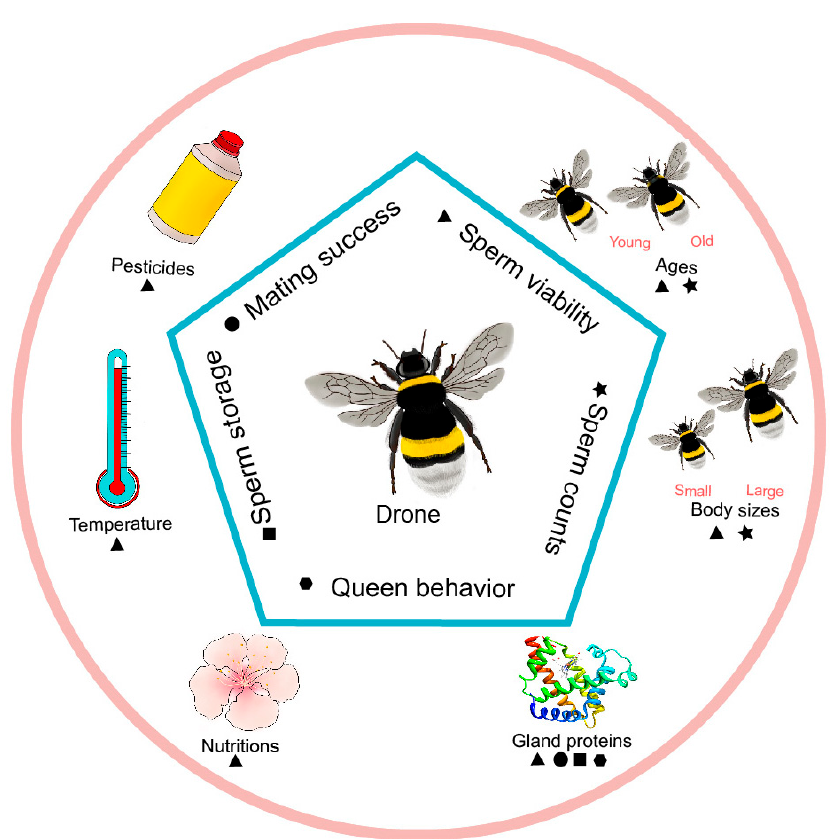
Figure 1. The main aspects of the reproductive ability of male bees are affected by various envi- ronmental factors and inherent characteristics, including ▲ sperm viability, ★ sperm counts, queen behavior, ■ sperm storage, ● mating